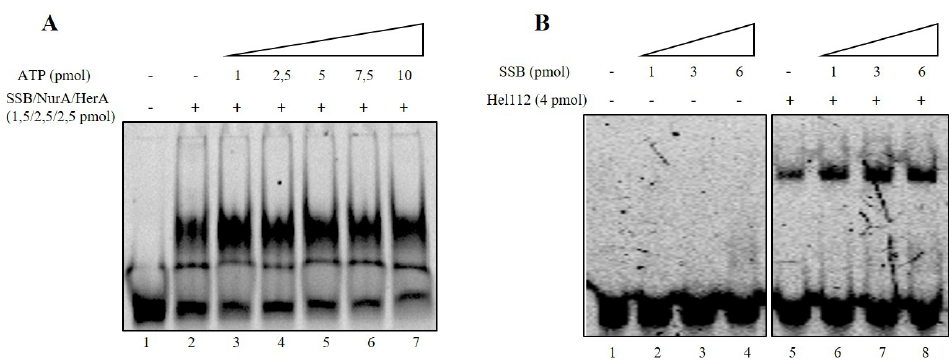
Figure 6. ( A ) Effect of ATP on NurA/HerA/SSB binding onto DNA. A fixed amount of NurA, HerA and SSB were analyzed for their binding onto DNA in absence (lane 2) and presence of increasing amounts of ATP (lanes 3–7). Lane 1 represents a negative control where no proteins were added to the reaction. ( B ) Hel112 effect on SSB binding onto DNA. Increasing amounts of SSB were analyzed for their binding onto DNA in the absence (lanes 2–4) or presence (lanes 6–8) of Hel112. Lane 5 refers to Hel112 binding to DNA, while lane 1 represents a negative control where no proteins were added to the